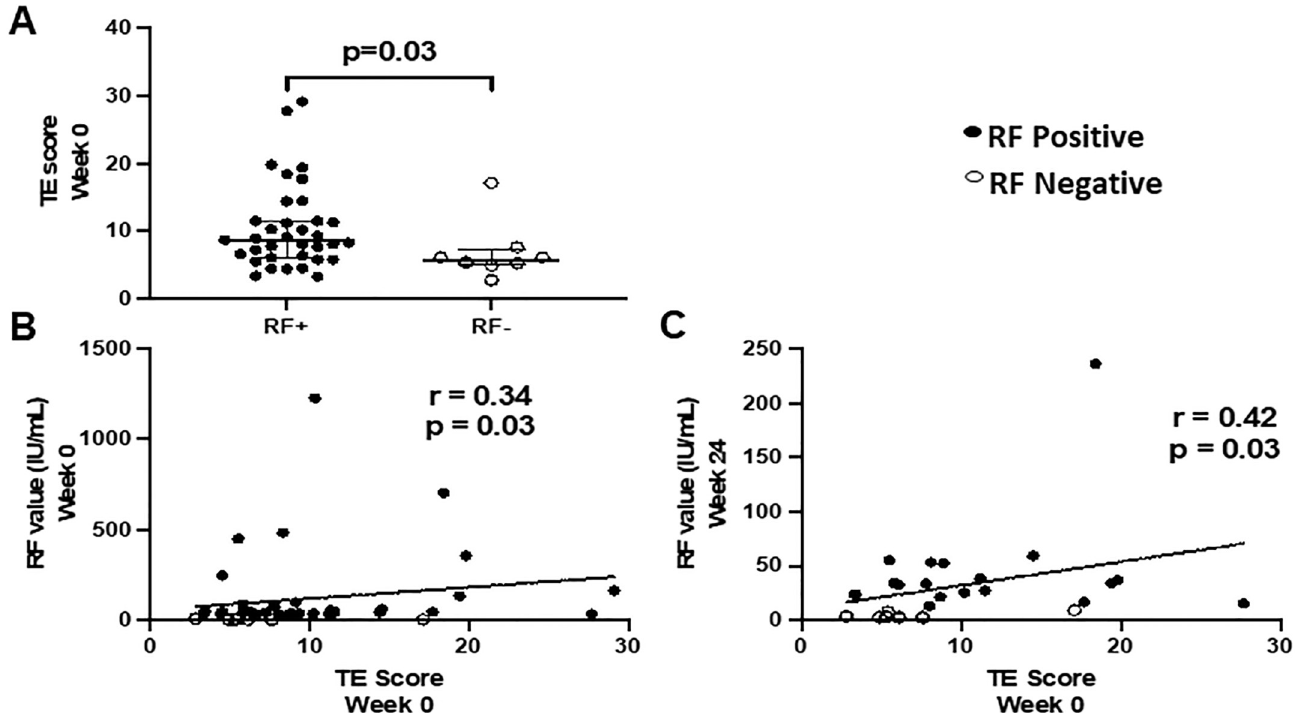
Fig 2. TE score is elevated in rheumatoid factor (RF) positive persons and the baseline TE score correlates with RF values over the course of hepatitis C virus (HCV) direct-acting antiviral (DAA) therapy. Panel A: TE scores prior to DAA therapy are shown for RF+ (n = 44) and RF- (n = 8) HCV infected persons. Correlations between baseline TE score and RF level at weeks 0 (panel B) and week 24 (panel C) are shown. Mann-Whitney test was used for comparison between two groups. Spearman’s Rho correlation was used to determine correlations between two values.